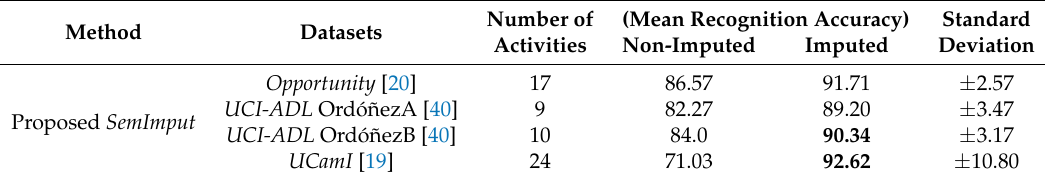
Table 6. Recognition accuracy gain using the proposed SemImput framework (Unit: %). Method